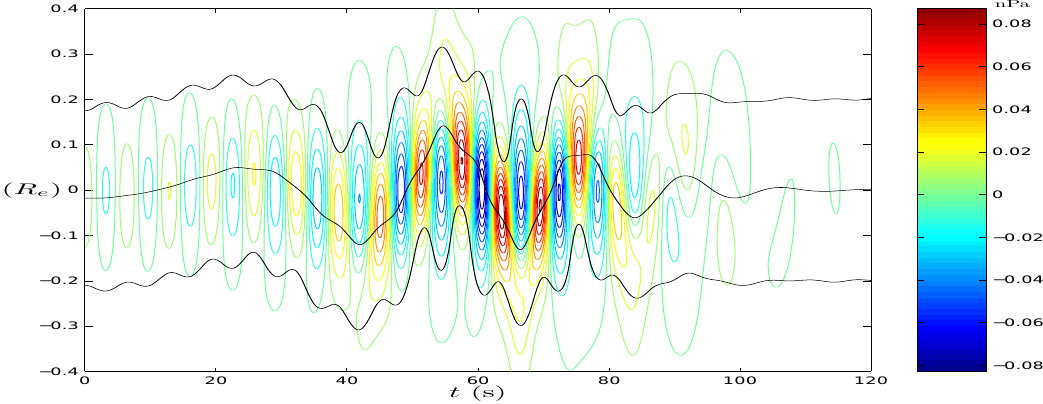
Fig. 42. Temporal evolution of the current sheet responding to an initial displacement located at 50 a = 10 R e . The three black lines correspond to a constant B x component and the colored isocontours represent the thermal pressure fluctuations. (From Fruit et al., 2004).